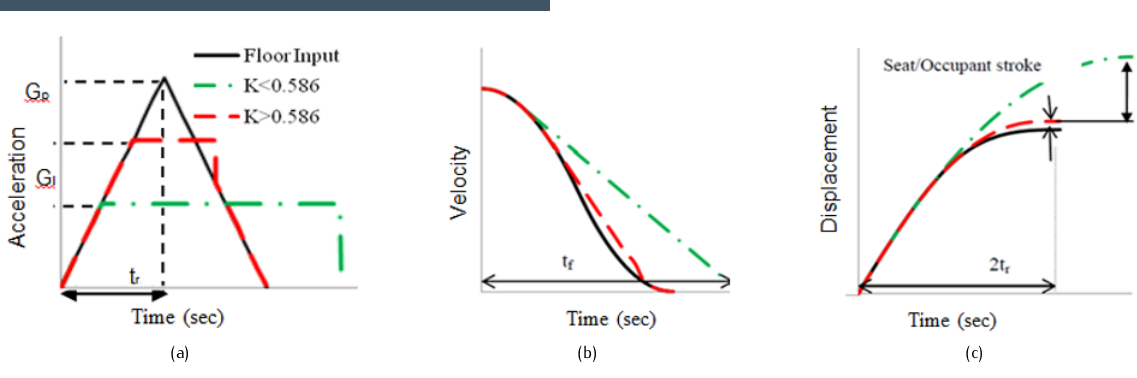
Figure 6. (a) deceleration, (b) velocity, and (c) displacement versus time for airframe and seat pan for K <